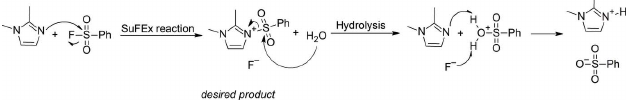
Figure 3 Proposed mechanism leading to the formation of the crystallized product reported herein.